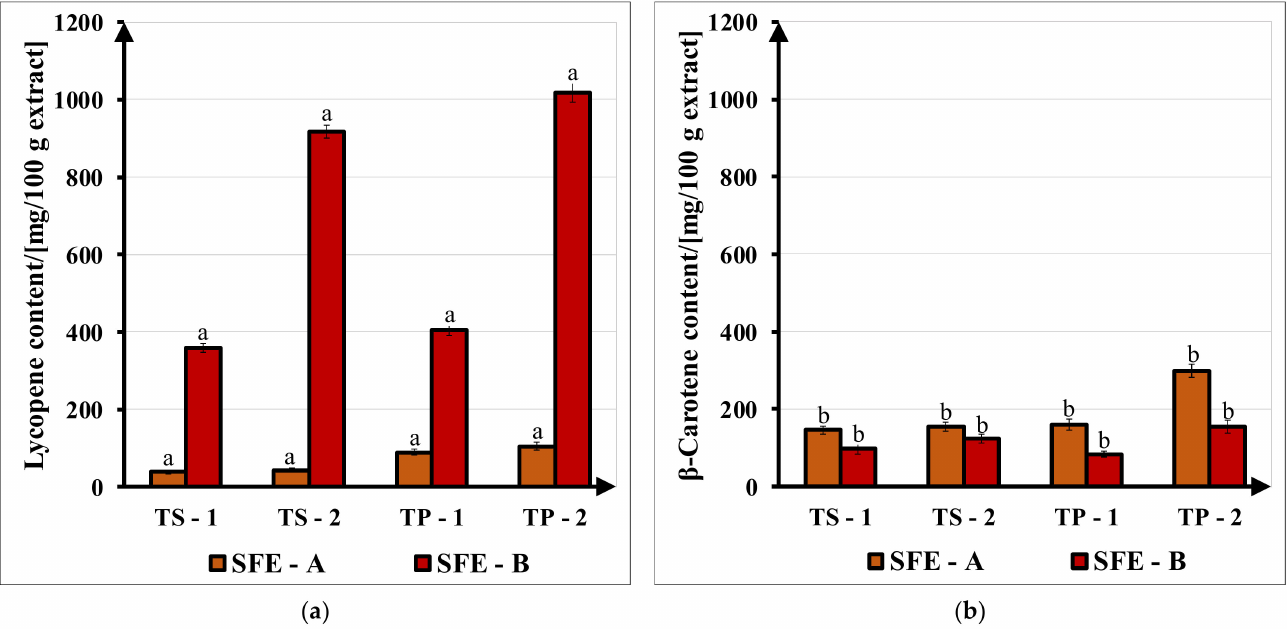
Figure 8. Carotenoid content of SFE fractions (SFE-A and SFE-B) obtained from tomato slices (TS) and tomato pomace (TP) with operating parameter set (1) at 400 bar, 70 ◦ C, 9 kg/h and set (2) at 450 bar, 70 ◦ C and 11 kg/h: ( a ) lycopene; ( b ) β -carotene. Different superscripts ( a , b ) indicate statistically different carotenoid concentration ( p < 0.05) at a level of significance α =